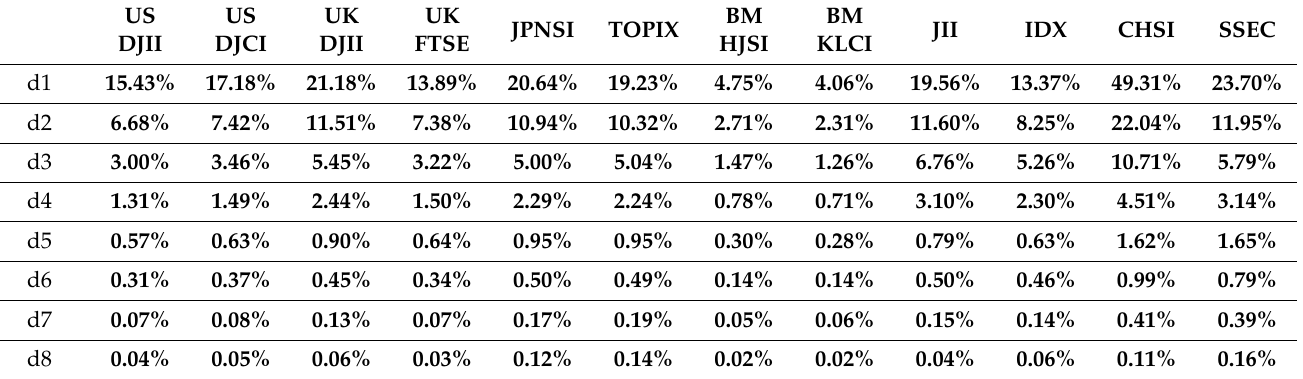
Table 6. MODWT variance decomposition